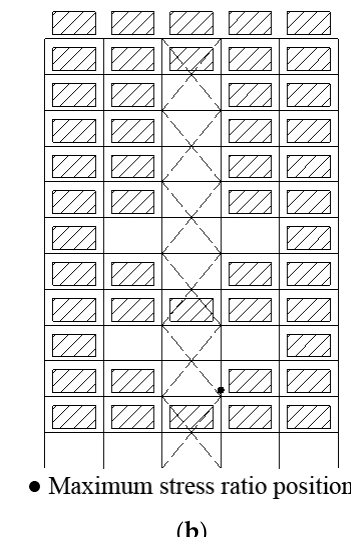
Figure 9. The most favorable distribution of load under 80% full load. ( a ) Tracking chart of optimization performance of GA. ( b ) The most favorable distribution of load (H = 6.71, P = 0).